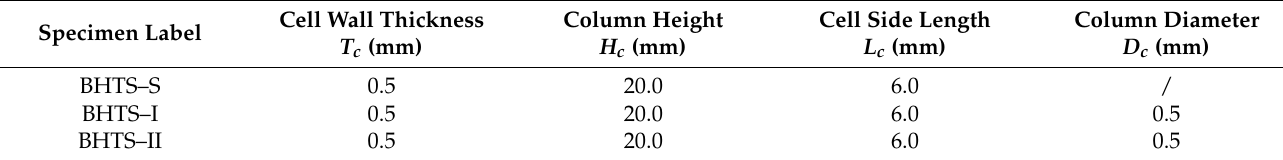
Figure 2. Types of BHTS. Table 2. BHTS parameters of the study. Table 2. BHTS parameters of the